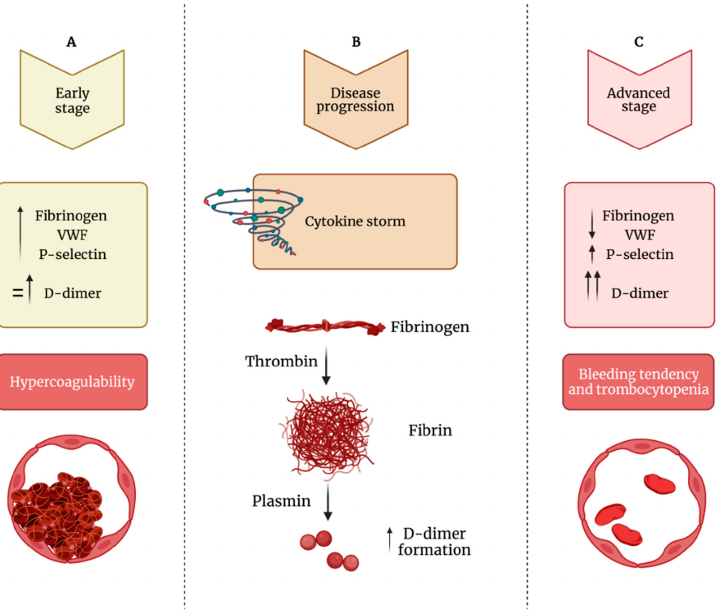
Figure 3. Impaired balance between hypercoagulability and bleeding tendency during COVID-19 progression. ( A ) During the early phase of the infection, patients show increased levels of fibrinogen, VWF (von Willebrand factor) and P-selectin and normal to mildly increased levels of D-dimer, leading to hypercoagulability. ( B ) During the disease’s progression, there is increased formation of D-dimer. ( C ) In the advanced stage of the infection, fibrinogen and VWF levels decrease, while D-dimer levels strongly increased; this phase is characterized by thrombocytopenia and bleeding diathesis.